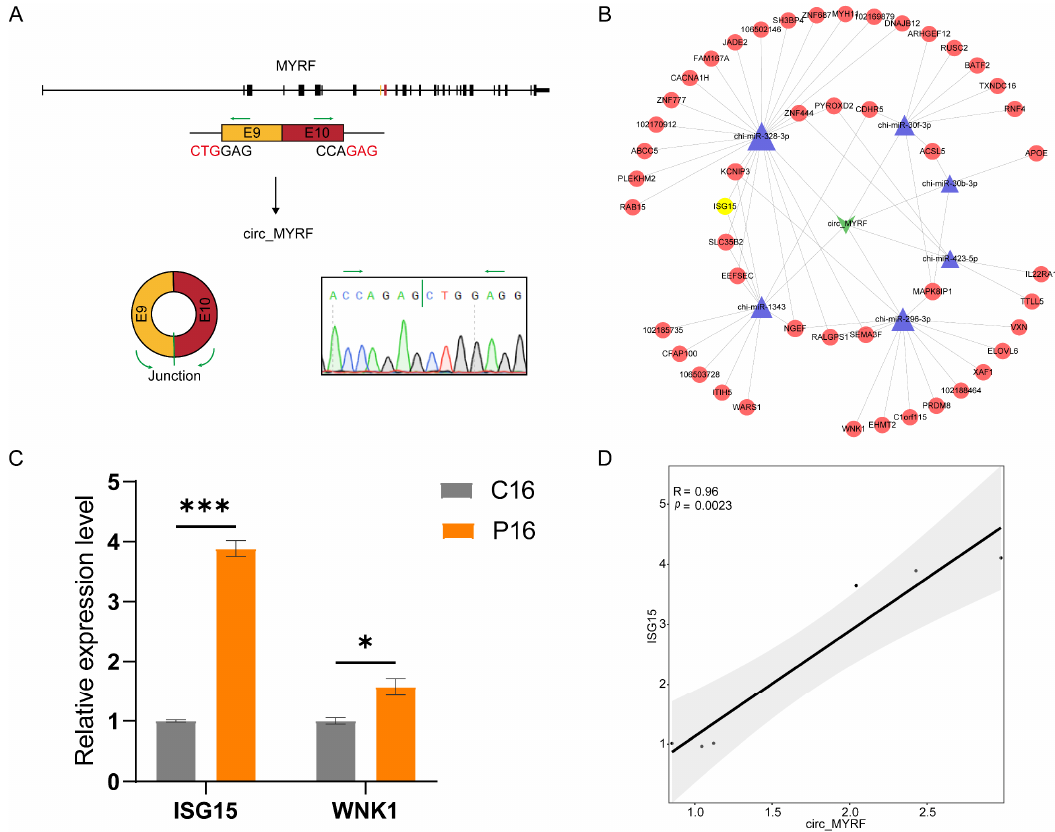
Figure 8. The characterization and putative function of circ_MYRF in the goat endometrium. ( A ) The genomic location of circ_MYRF in the host gene, MYRF . The expression of circ_MYRF was validated by qPCR and Sanger sequencing. Arrows represent divergent primer binding sites in the circular junction of circ_MYRF. ( B ) A putative ceRNA network of circ_MYRF. The green quadrilateral represents circ_MYRF, the blue triangles represent targeted miRNAs, and the red circles denote targeted mRNAs. The yellow circle represents the ISG15 mRNA. ( C ) Relative expression level of two randomly selected target genes in the ceRNA network determined by qPCR. Values represent mean ± SEM. *, p < 0.05; ***, p < 0.001. ( D ) The correlation between circ_MYRF expression and ISG15 expression.